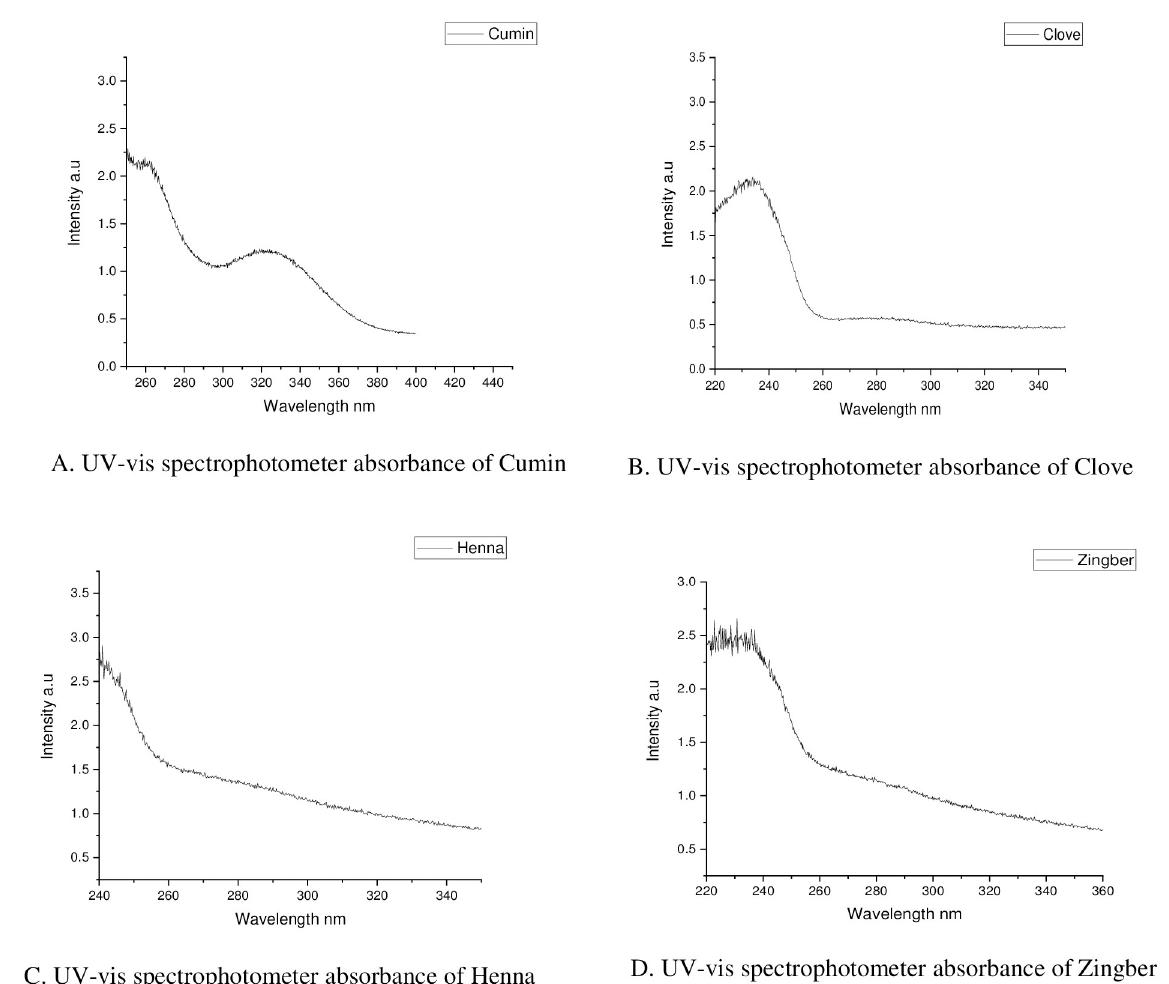
Fig 1. UV-vis spectrophotometer absorbance of different essential oils nanoemulsions.